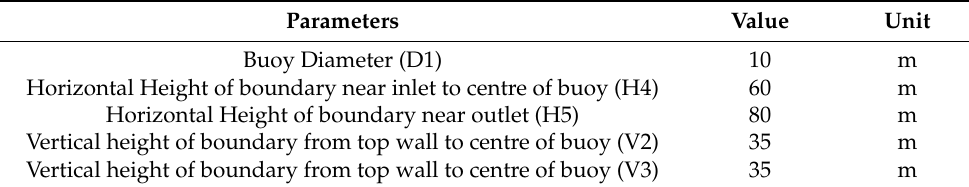
Table 7. Parameters for 2D CFD buoy model in ANSYS Fluent.